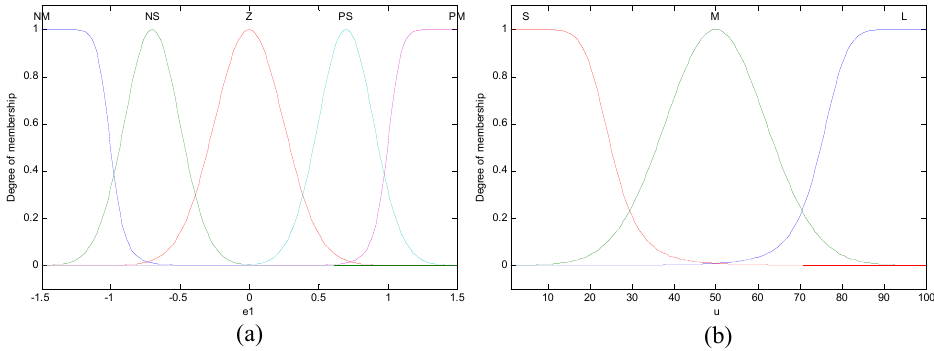
Figure 6. ( a ) Fuzzy membership functions for input e 1 . ( b ) Fuzzy membership functions for input e 2 . ( c ) Fuzzy membership functions for output λ a .